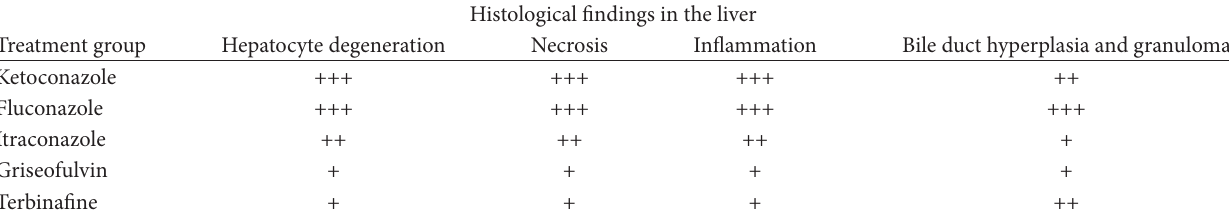
Table 3: Histopathological findings in livers of treatment with antifungal